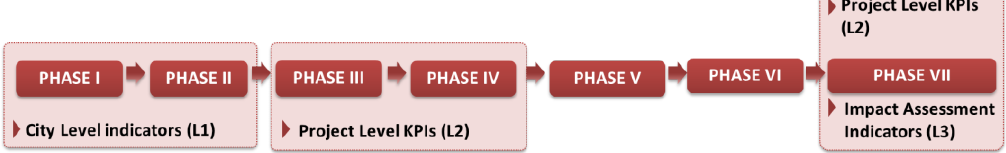
Figure 4. Integration of the three levels of indicators in the Methodology